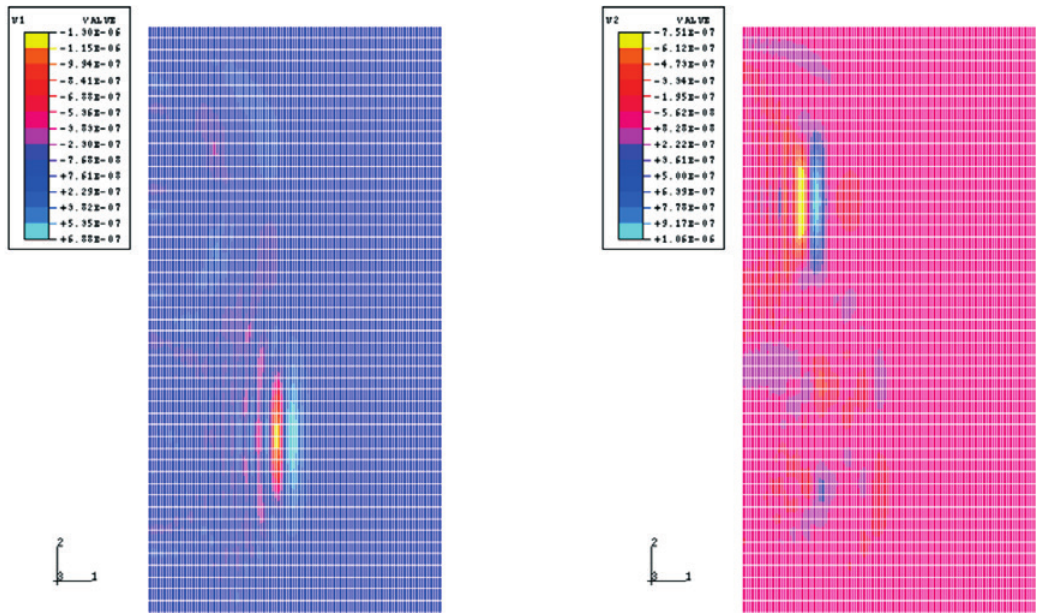
Displacements corresponding to the longitudinal (left, displacement U1) and transverse wave (right, displacement U2) propagation through the specimen between the zero-crossings of the transmitted and received waves. Displacements of some representative nodes in the FEM are shown in Figure 8. In the figure, displacements corresponding to the propagation of the transverse wave and longitudinal wave along the centers of the transmitting and receiving transducers are represented; lines S1 and L1 correspond to the transmitted wave (center of transmitter transducers), S2 and L2 corresponds to a point in the middle of the pulse path, and S3 and L3 correspond to the node at the center of the receiver transducer. As shown on Table 4, the values of the velocities calculated using the finite ele -